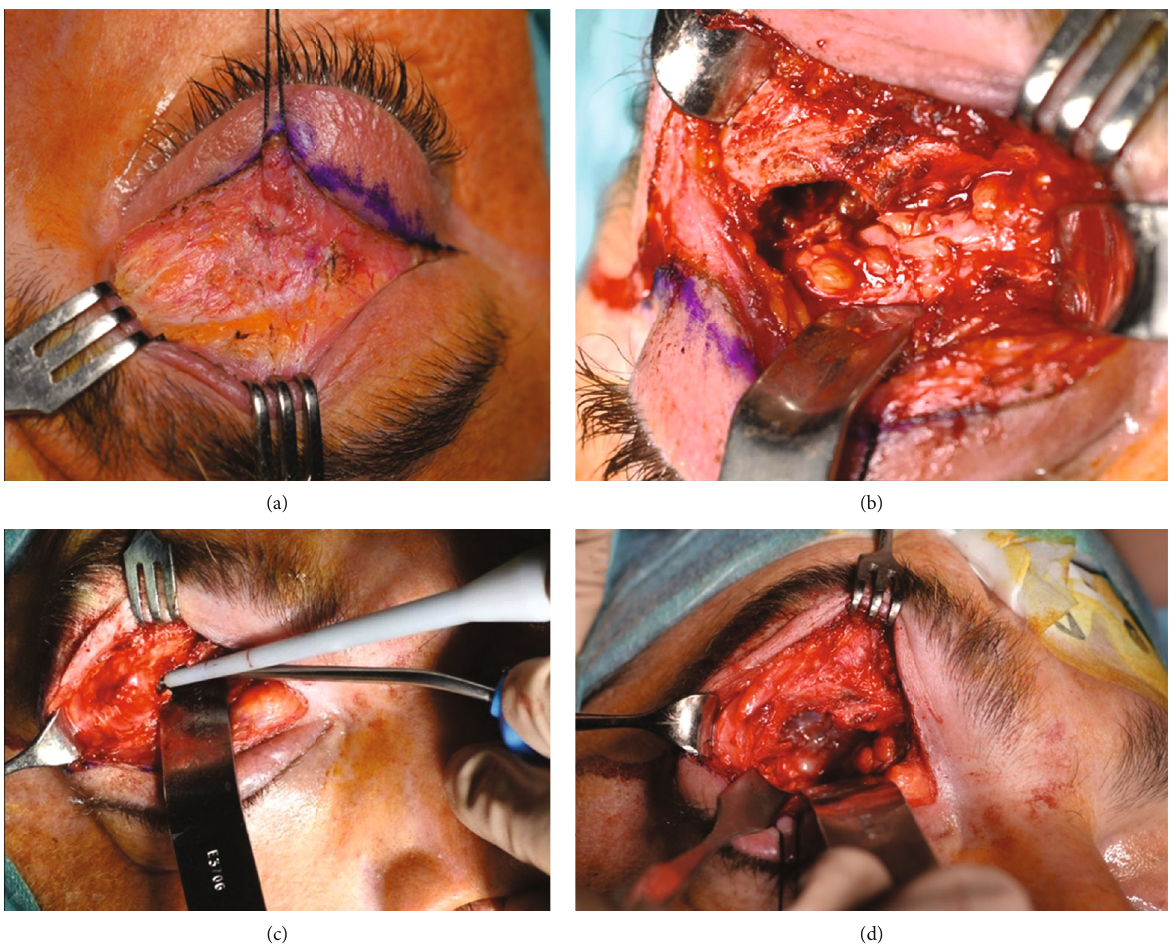
Figure 2: (a) Surgical approach through an upper eyelid crease incision to access the orbital roof. Intraoperative photograph showing bone destruction in the roof of the orbit and the presence of a red-yellowish mass, with evidence of dark coagulated blood and fragments of bone within the soft tissue. The tumor extends into the anterior cranial fossa. (b) The handpiece of SONOPET® ultrasonic aspirator used for aspiration and emulsi fi cation of the tumor tissue in the superior orbit and its extension into cranial cavity. (c) Resection of abnormal tissue from the upper orbit and its extension into anterior